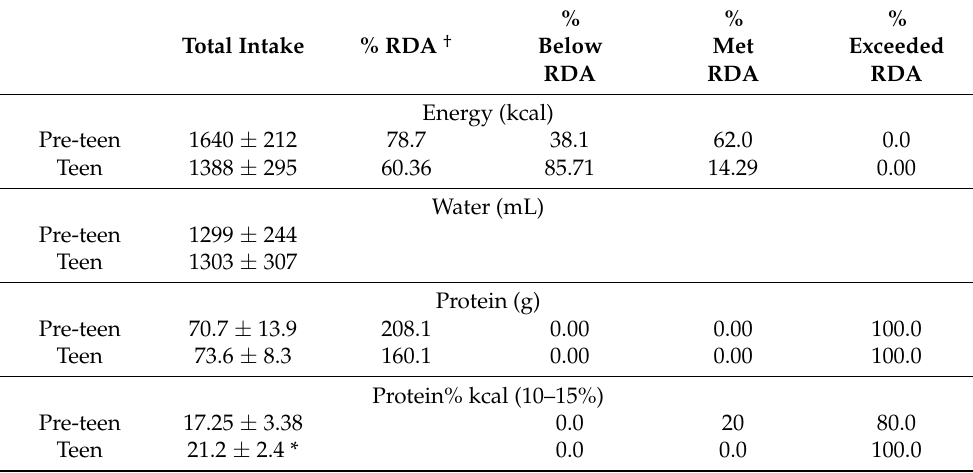
Table 2. Energy, macronutrient intake and percentage of Recommended Dietary Allowance (RDA) in pre-teen (9- to 12-year-old) and teen (13- to 18-year-old) gymnast groups ( n = 17 and n = 13,